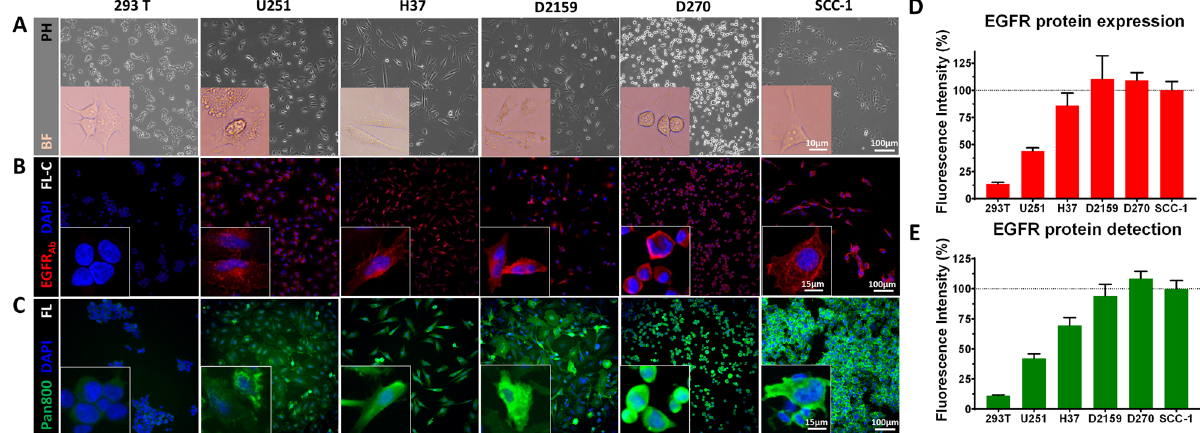
Figure 1. Panitumumab-IRDye800 specifically detects EGFR protein expression in human malignant glioma cells. ( A ) Phase contrast (PH) microscopy images confirmed the healthy growth and expected morphology of six cell lines in vitro before EGFR immunostaining, including human xenograft glioma cell lines (D270, H37, D2159 and U251), positive control (SCC-1) and negative control (293 T). Insets : bright field (BF) microscopic images of individual cell morphology. Fixed cells were immunostained with ( B ) a commercial EGFR antibody and ( C ) panitumumab-IRDye800 (pan800). Insets : high magnification views of plasma membrane